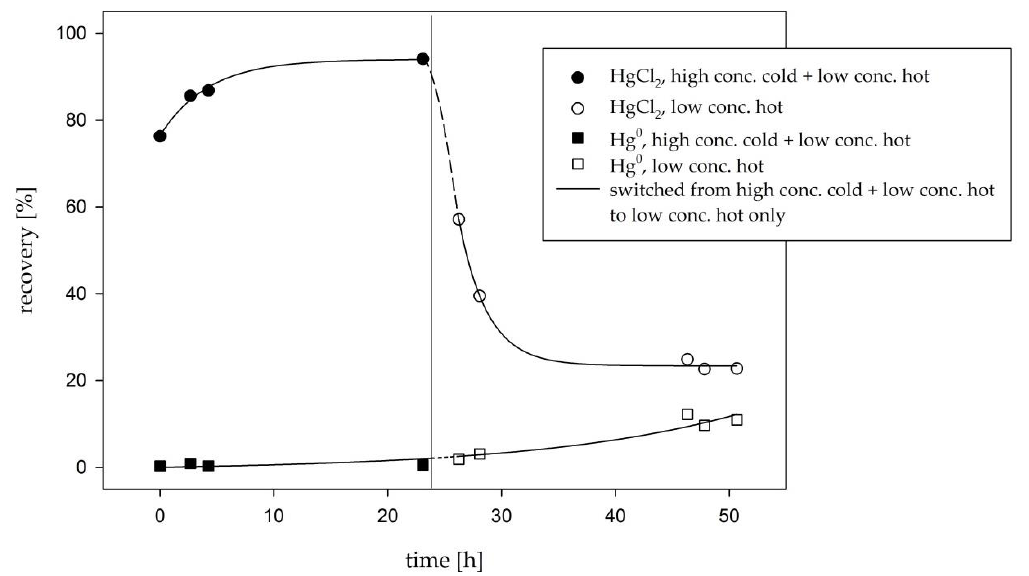
Figure 6. The characterization of the calibrator output when using high HgCl 2 concentrations (a combination of cold and hot HgCl 2 ) and after switching from high to low HgCl 2 concentrations (hot HgCl 2 only). The data points labelled “high conc. cold + low conc. hot” were obtained while the gas was comprised of a cold Hg (12.6 µg m −3 , “saturating” concentration) and a hot Hg (5.90 ng m −3 , low concentration) mixture. The data points labelled “low conc. hot” were obtained while the gas was comprised of only a hot Hg (low concentration). The continuous lines connecting the data points are estimations of the time trend using different regressions, and the dashed lines are extrapolations of the said regressions.